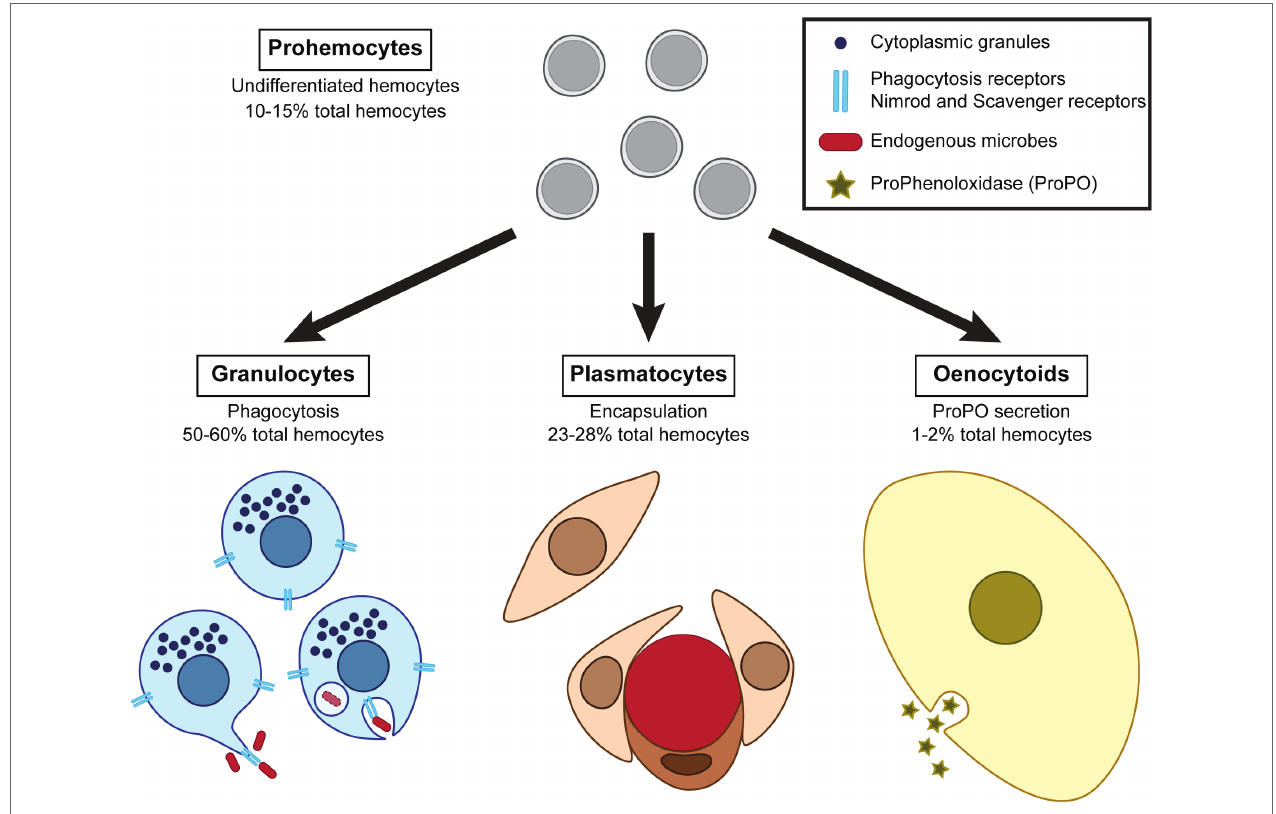
FIGURE 2 | Diversity of the hemocytes composing T. molitor cellular immune response and their associated